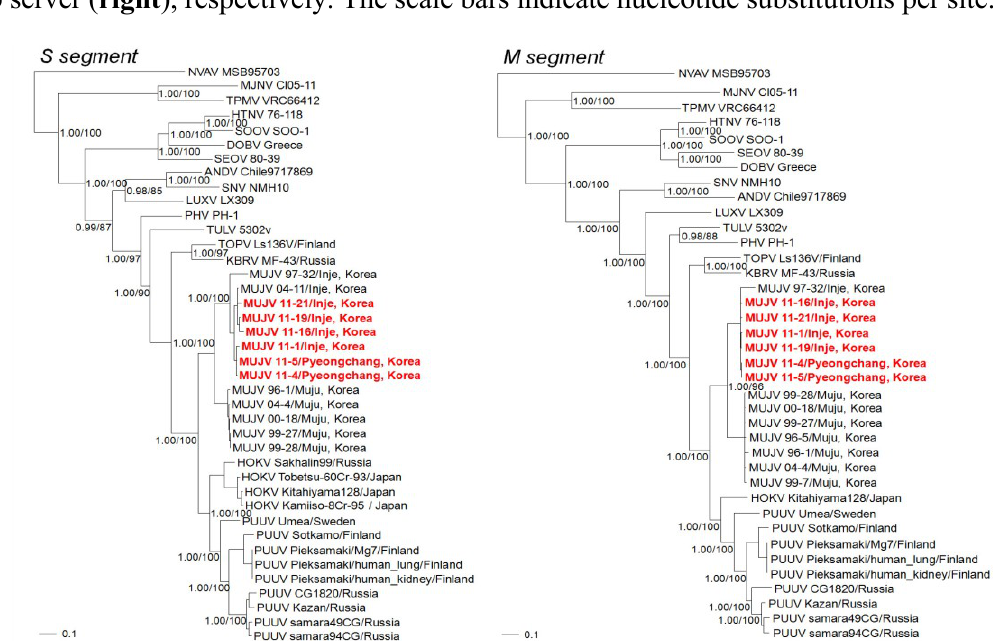
Figure 2. Phylogenetic trees were generated by the maximum-likelihood and Bayesian methods, using the GTR + I + Γ model of evolution, based on the alignment of the S-, M- and L-segment sequences of MUJV strains. Since tree topologies were very similar using RAxML and MrBayes, the trees generated by MrBayes were displayed. The phylogenetic positions of MUJV (96-1: DQ138133, DQ138132; 96-5: DQ138134; 97-32: DQ138136, DQ138125; 99-7: DQ138137; 99-27: DQ138140, DQ138139; 99-28: DQ138142, DQ138141; 00-18: